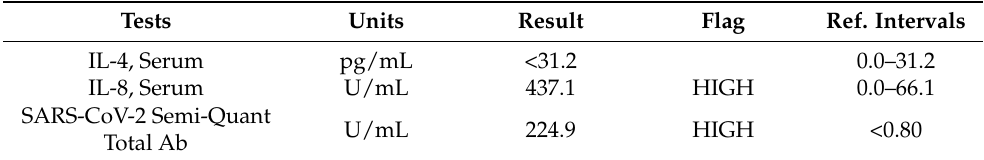
Table 6. Interleukin and antibody tests after